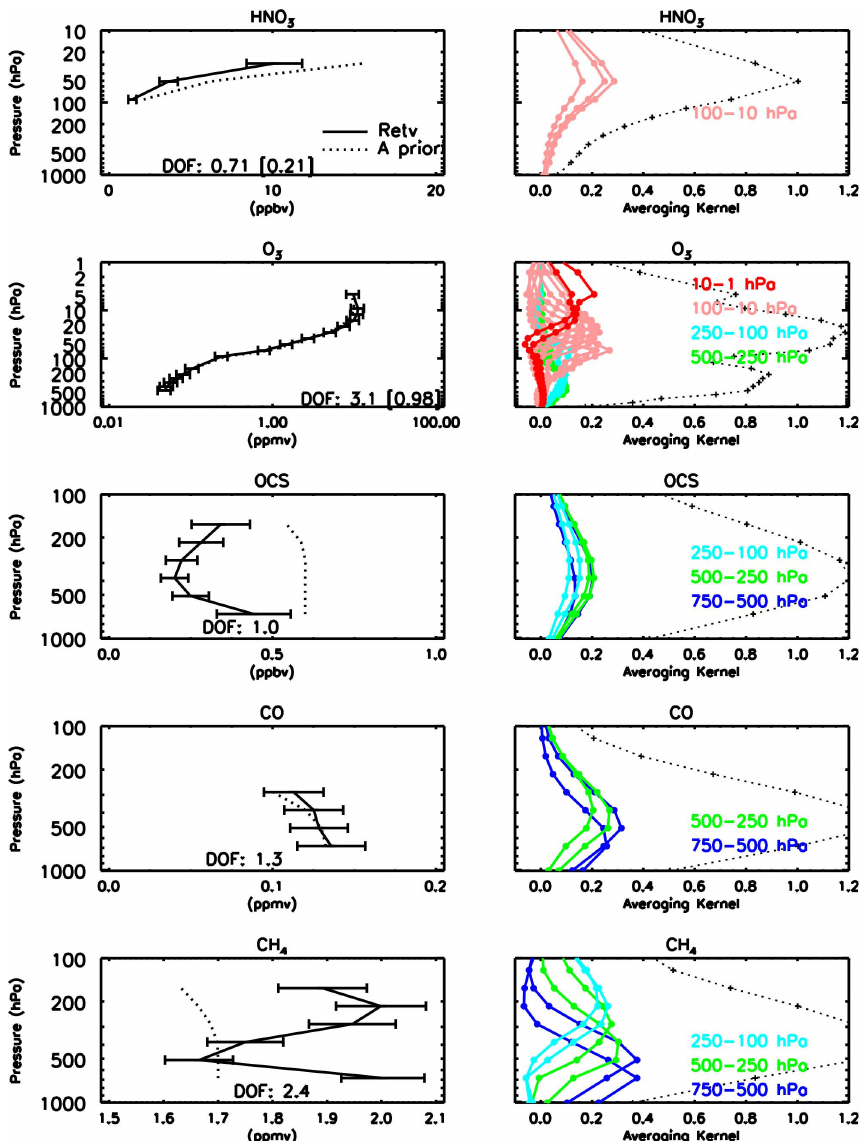
Fig. 11. Left: Tropospheric trace gas profiles and retrieval errors from the ocean case over the Gulf of Mexico. Right: Corresponding averaging kernels (in color) and sum of the rows of the averaging kernel (in